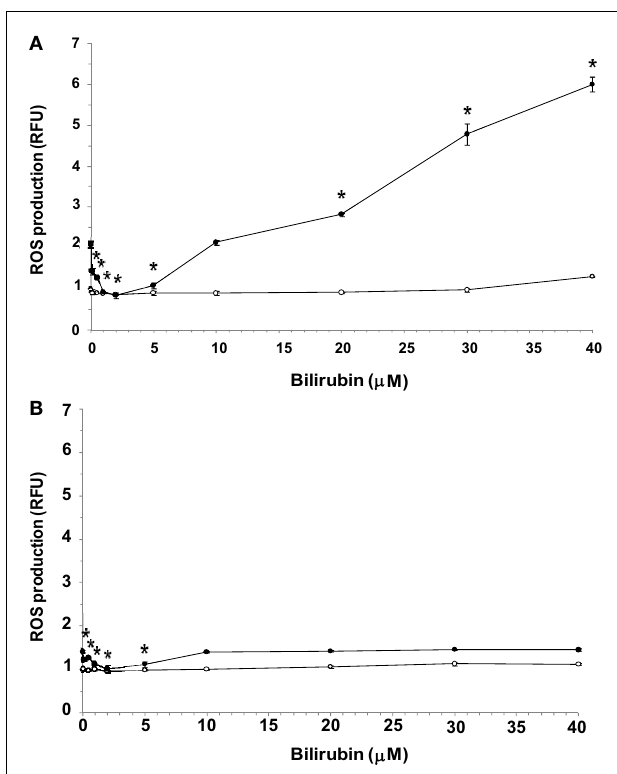
FIGURE 3 | Effects of UCB on the generation of ROS in microvascular endothelial cells cultured in normal or high glucose-containing media. Confluent cultures of bEnd3 (A) or MS1 (B) cells were incubated for 48h ◦ • with culture medium containing normal (5.5mM; - -) or high (25mM; - -) glucose, in the absence or presence of increasing concentrations of UCB added during the last 24h of incubation. ROS production was assessed using the cell-permeant probe CM-H 2 DCFDA, as described in Materials and Methods. ROS production was normalized by determining protein content and is expressed as relative fluorescence units (RFU), calculated by dividing the individual fluorescence values for the different treatments by that obtained for cells exposed to 5.5mM glucose in the absence of UCB (the latter were assigned a value of 1). Experiments were repeated at least three times.The results of a representative experiment are shown as Mean ± Standard Deviation. *Statistically significant difference from 0 µ M UCB at p <